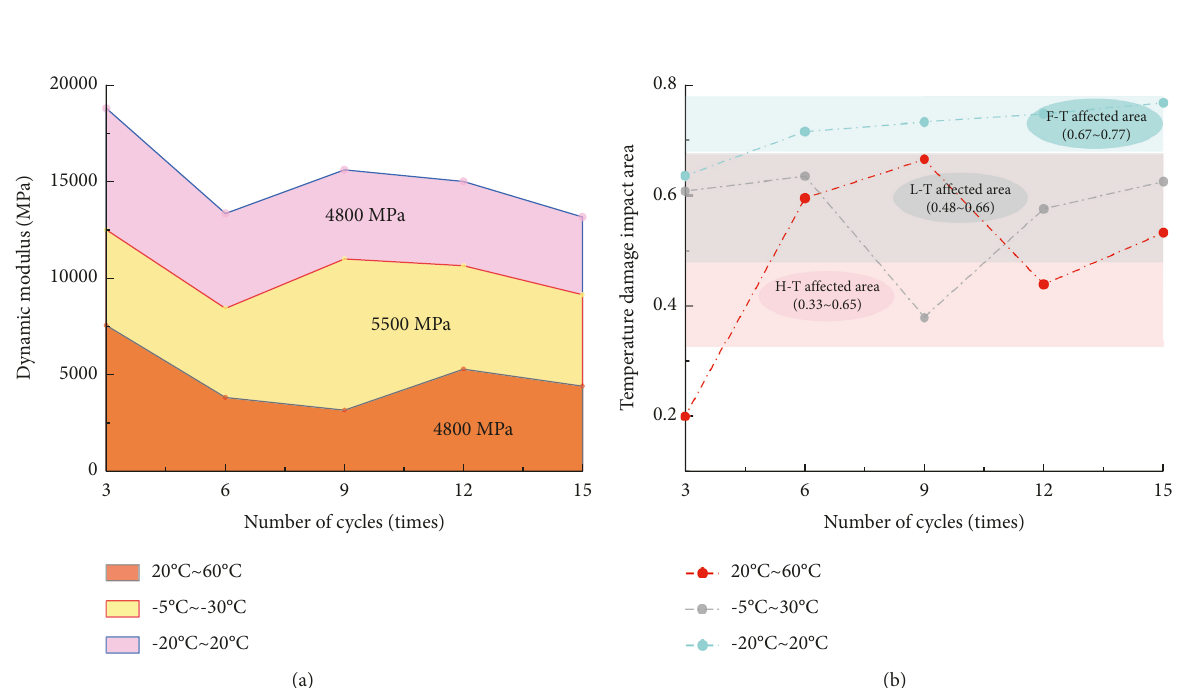
Figure 3: Variation of dynamic modulus of semirigid base material under different temperature intervals. (a) Dynamic modulus stacking diagram at different temperature intervals. (b) Temperature damage impact